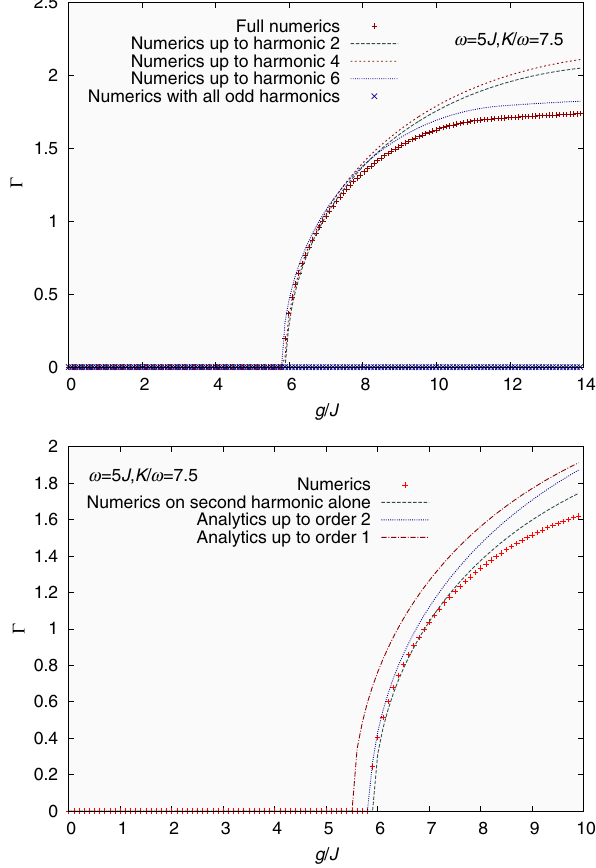
FIG. 7. Top panel: Instability rate Γ as a function of the interaction strength g for ω ¼ 5 J and K= ω ¼ 7 . 5 , numerically computed from the Bogoliubov equations (cf. Sec. II), taking into account only a few harmonics of the modulation in the function h t Þ . As theoretically predicted from the expression of h q ð [Eq. (20)], the odd harmonics do not contribute, while the first even ones successfully describe the full numerical calculation. Bottom panel: Comparing the analytical and numerical results for the instability rate Γ ð g Þ , using the same parameters as above. The red crosses correspond to the full numerical solution, while the blue dashed lines are numerically obtained by only taking the second harmonic of the drive into account. As generically observed in the A zones of the stability diagram (Fig. 2), the numerical instability rates are well captured by the perturbative analytical approach, implemented here up to order 1 (red dotted- dashed line) and 2 (blue dotted